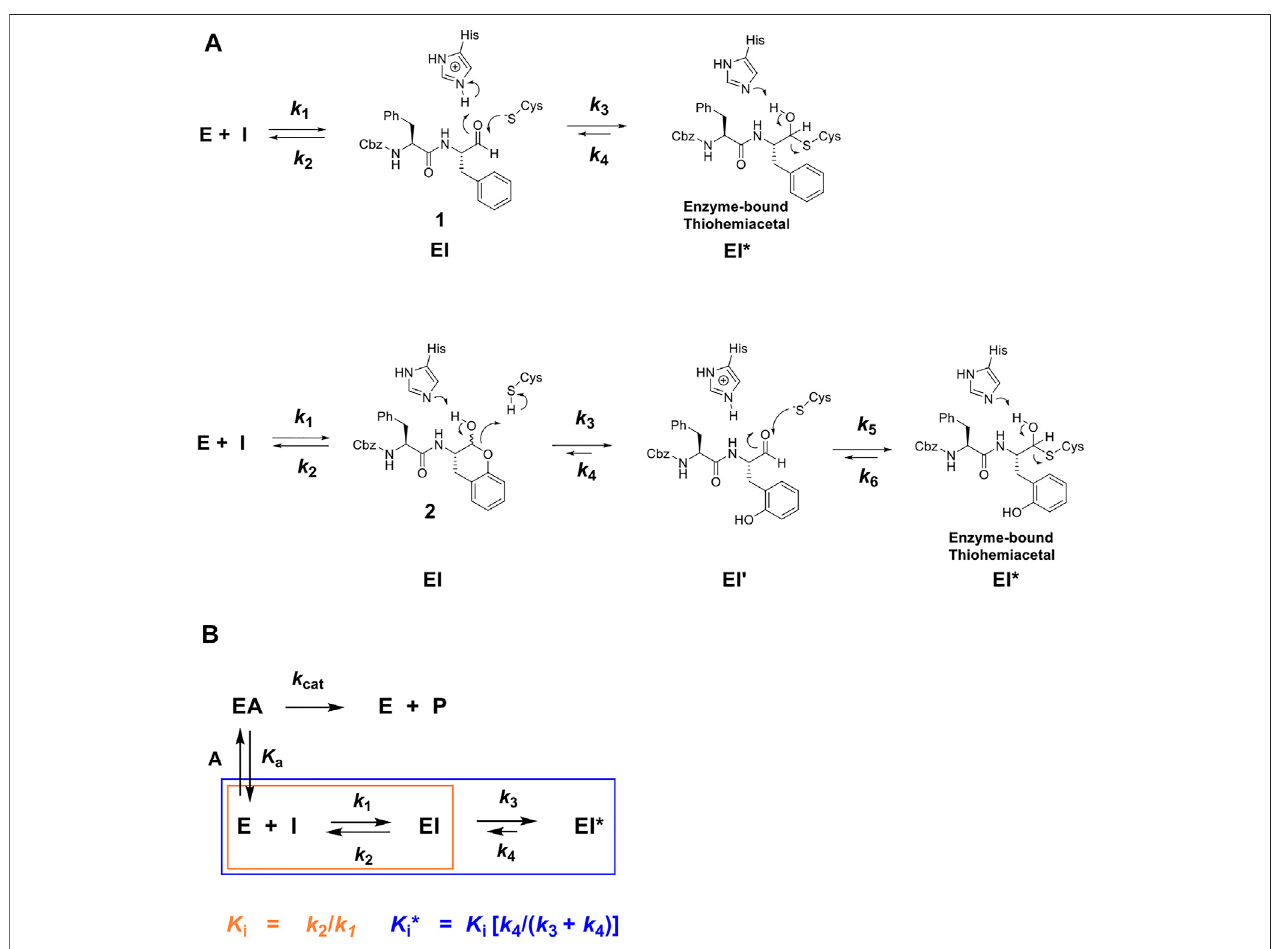
FIGURE1|(A) PutativechemicalmechanismsofreversiblecovalentinhibitionofacysteineproteasebyCbz-Phe-Phe-CHO( 1 )anditsself-maskedaldehydeanalogue 2 (Li et al., 2021). Dipeptide aldehyde 1 binds to free enzyme E to form an EI complex, which apparently undergoes a reaction with the active-site to form a thiohemiacetal adduct( k 3 ), the EI* complex,which can slowlyrevert via the k 4 steptore-form the aldehyde. The self-masked aldehyde ( 2 ),isa o -tyrosinylanalogueof 1 , which existsinthe solutionasa δ -lactol;the form which bindstothe protease. The cysteineproteaseapparentlycatalyzes the ring-opening ofthe lactol(The k 3 step),toafford the bound aldehyde( EI ’ ),whichproceedstoformthereversibly-covalent EI* complex(Lietal.,2021). (B) Kineticschemefortime-dependentinhibitor I whichcompeteswithsubstrate A for free enzyme E to rapidly form complex EI (described by inhibition constant Ki , orange), which after minutes forms slowly-reversible complex EI* (described by inhibition constant Ki* , blue), for which Ki > Ki*